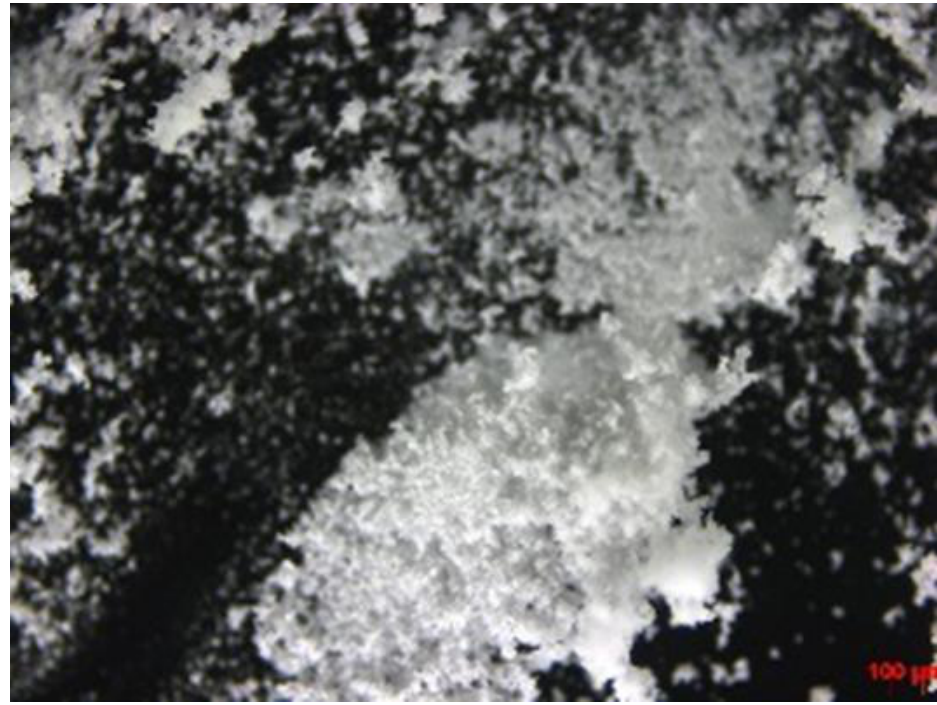
Figure 3. DPZ white powder under optical microscopy , scale bar: 100 μm .